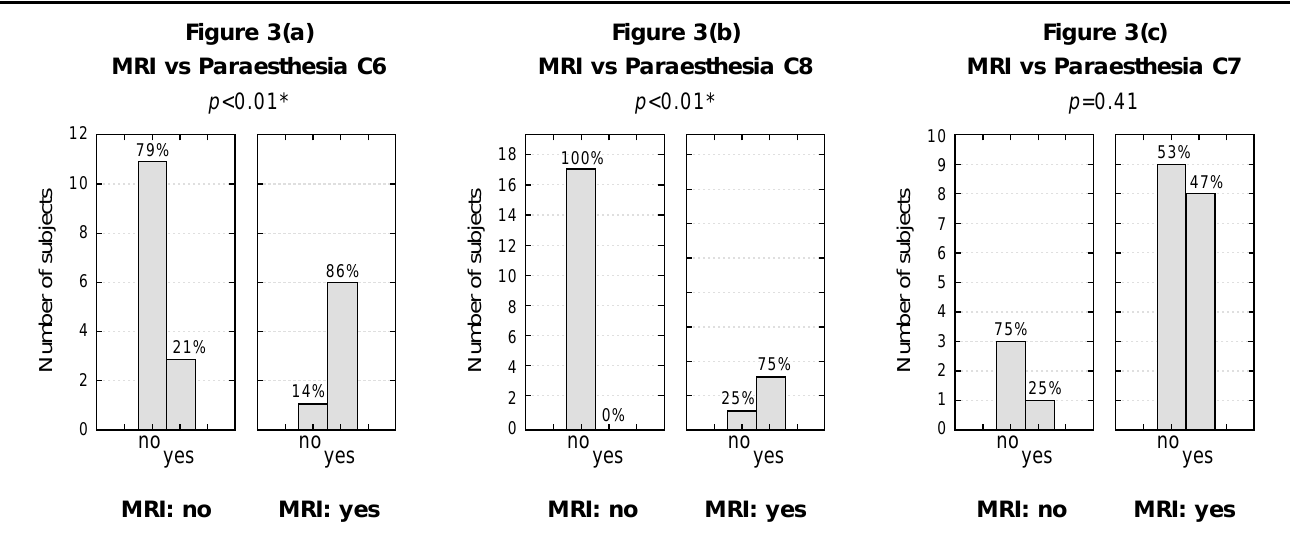
Figure 3: Comparison between MRI findings and dermatomal area(s) of paraesthesia as determined during the interview for (a) C6, (b) C8 and (c) C7 NR involvement (Fisher exact, one-tailed test and categorized